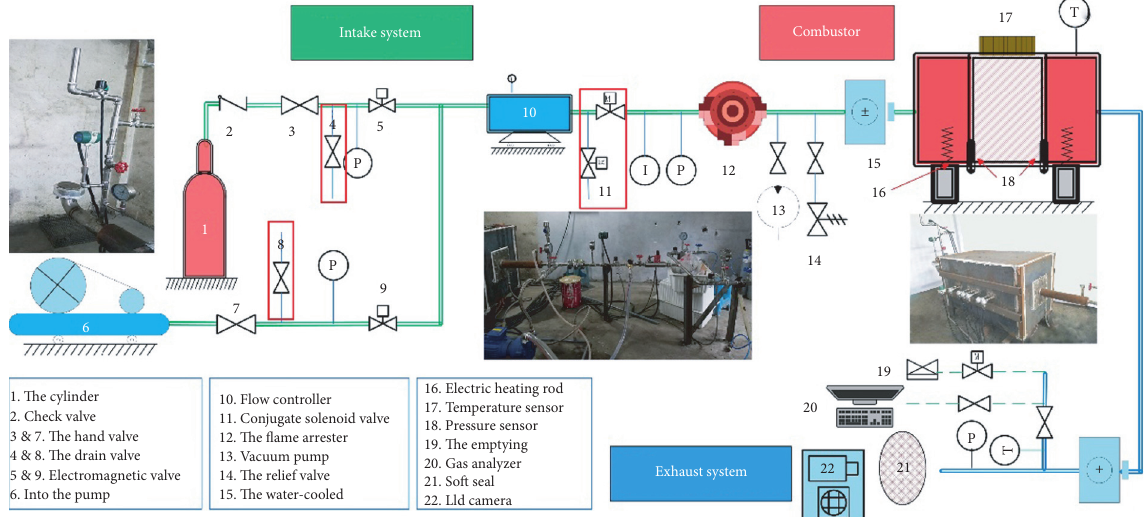
Figure 1: Regenerative oxidation equipment